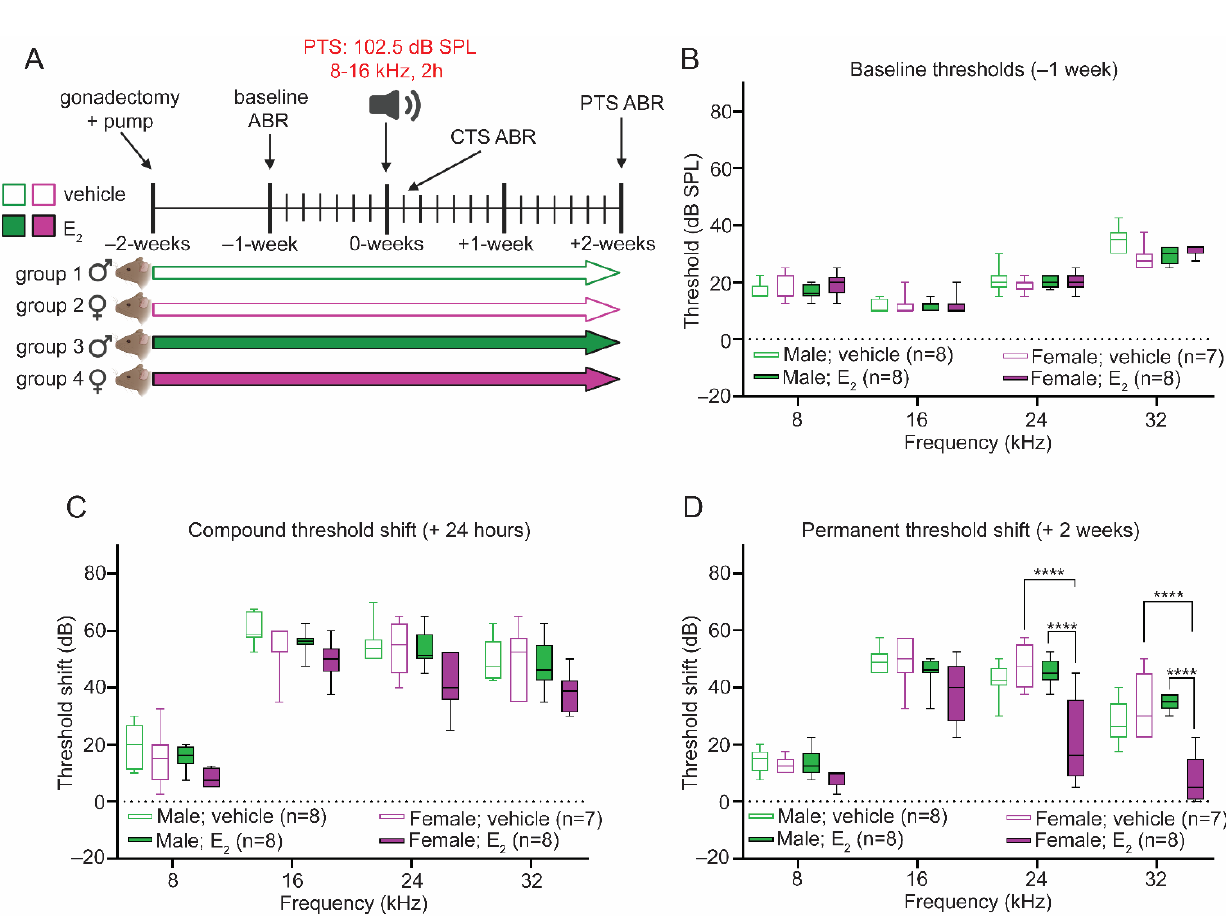
Figure 3. E 2 -replacement in gonadectomized female mice protects against hearing loss following a PTS-inducing noise exposure. ( A ) Experimental schematic. Male and female mice were gonadectomized at 8-weeks of age and implanted with an osmotic pump to deliver vehicle or E 2 (1 µg/day) for the duration of the study. Animals were exposed to a permanent threshold shift (PTS)-inducing noise (102.5 dB SPL, 8–16 kHz, 2-h) at 10-weeks of age. Auditory thresholds were quantified via ABR measurements 1-week pre-exposure (baseline), 24-h post-exposure (compound threshold shift or CTS), and 2-weeks post-exposure (permanent threshold shift or PTS). ( B ) Vehicle-treated and E 2 -treated male and female mice display similar baseline ABR thresholds. ( C ) Twenty-four hours post-exposure, vehicle-treated and E 2 -treated male and female mice display a CTS of a similar magnitude at all frequencies examined. ( D ) Two-weeks post-exposure, E2-treated female mice display a reduced PTS compared to E 2 -treated males at 24 kHz ( p < 0.0001) and 32 kHz ( p < 0.0001) and compared to vehicle-treated females at 24 kHz ( p < 0.0001) and 32 kHz ( p < 0.0001). Vehicle-treated male and female mice display a PTS of a similar magnitude across all frequencies tested. Similarly, vehicle-treated and E 2 -treated males displayed no differences in the magnitude of the PTS across all frequencies tested. ABR thresholds were compared using a 3-way ANOVA followed by Tukey’s post-hoc test. n = number of mice; ABR thresholds: minimum value, 1st quartile, median, 3rd quartile, maximum value; **** p < 0.0001.